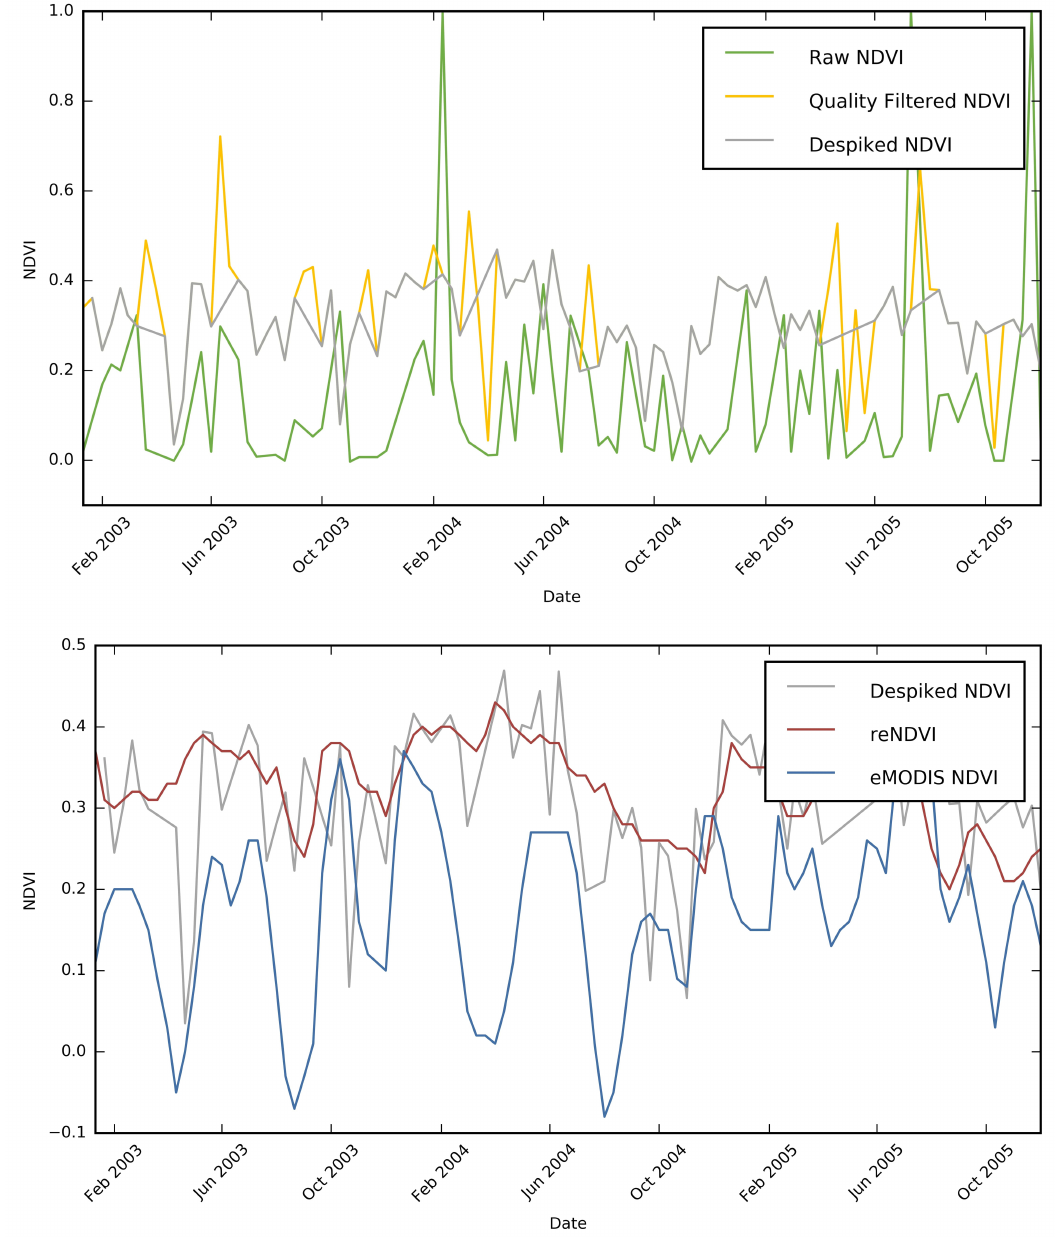
Figure 4. Raw NDVI compared to quality filtered and despiked NDVI ( top ) and despiked compared to eMODIS NDVI and reNDVI ( bottom ) for a mountain pixel with coordinates [37.3030, −